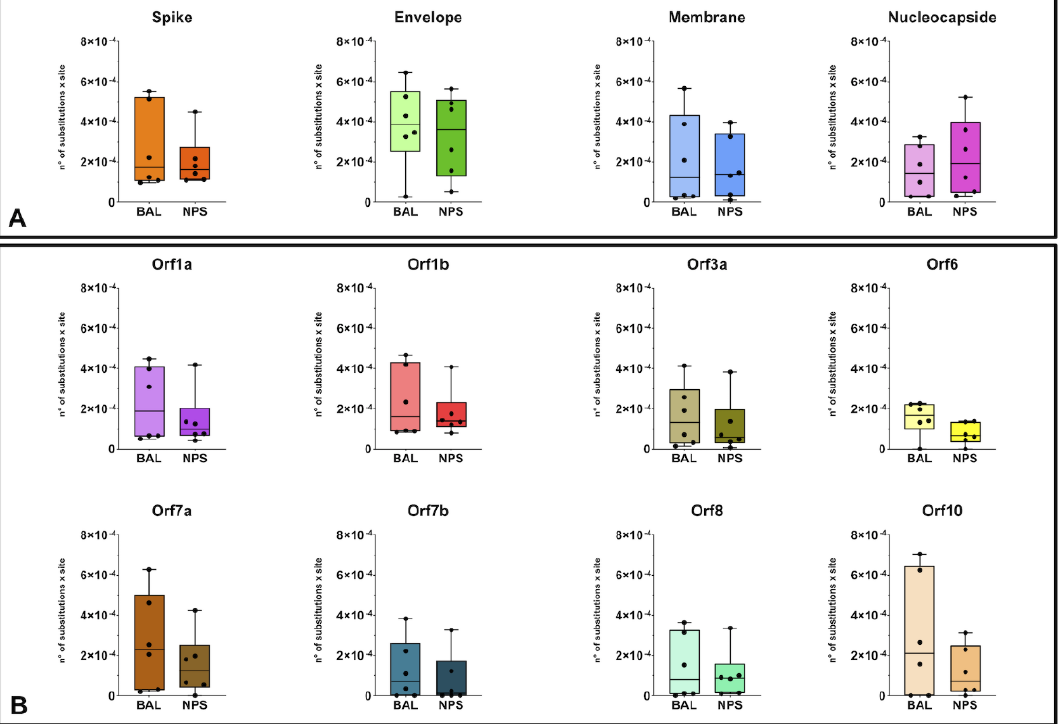
Figure 2. Intra-host nucleotide diversity of SARS-CoV-2 genomic regions in BAL and NPS samples: ( A ) structural proteins regions; ( B ) non-structural proteins regions.